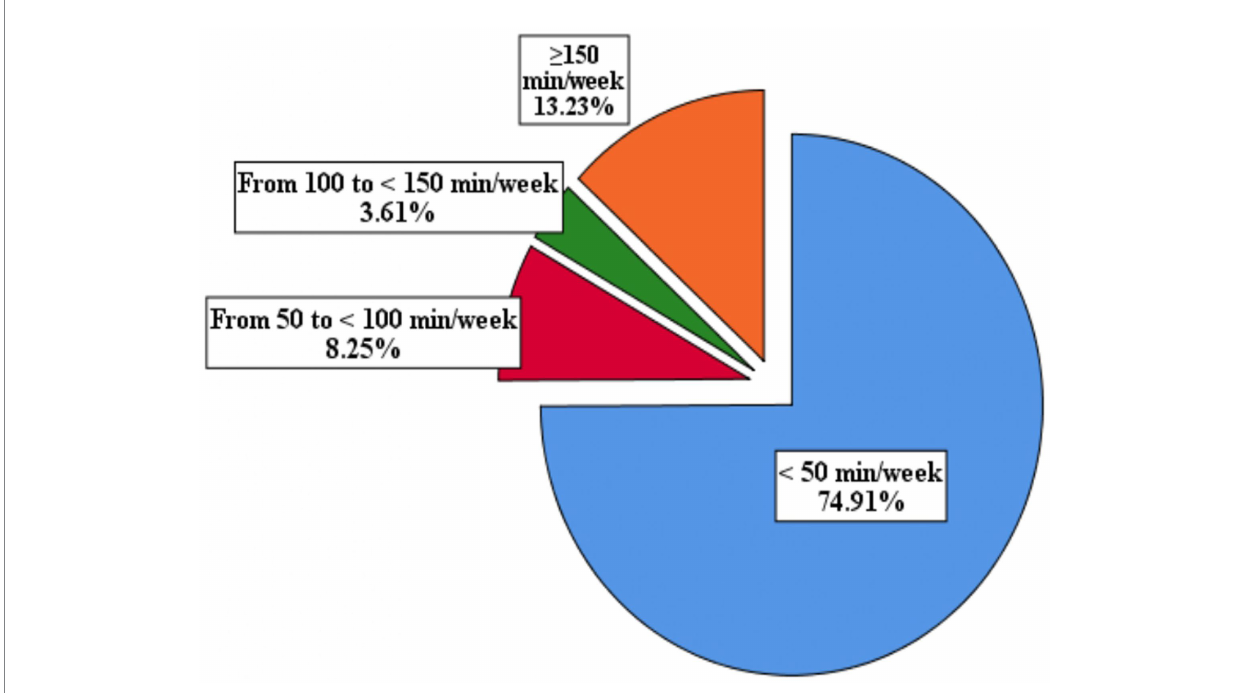
FIGURE 2 Exploration of weekly physical activity duration in Saudi participants with physical disabilities ( N =